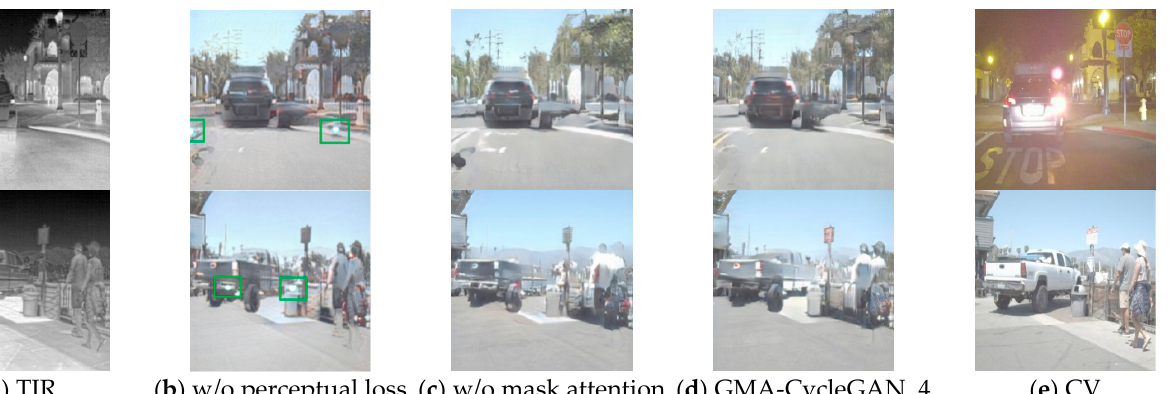
Figure 6. Comparisons of different ablation studies for GMA-CycleGAN_4.